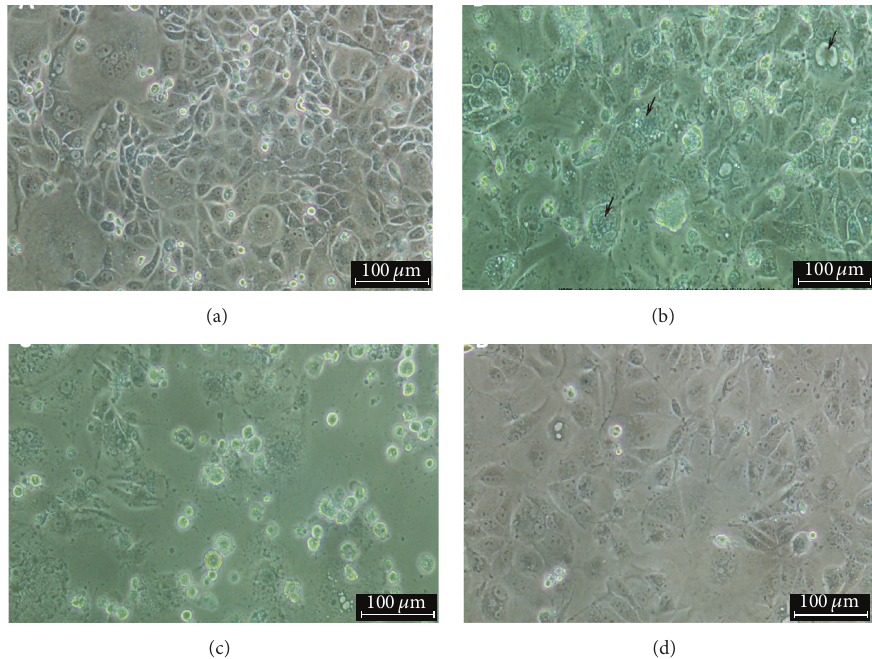
Figure 2: Infection of MDCK cells with virus suspension revealed evidences of virus growth as demonstrated by CPE which is characterized by cell ballooning, granulation, formation of giant cells (arrow), rounding, and cell detachment as infection progresses 3 dpi (a); 5dpi (b) and